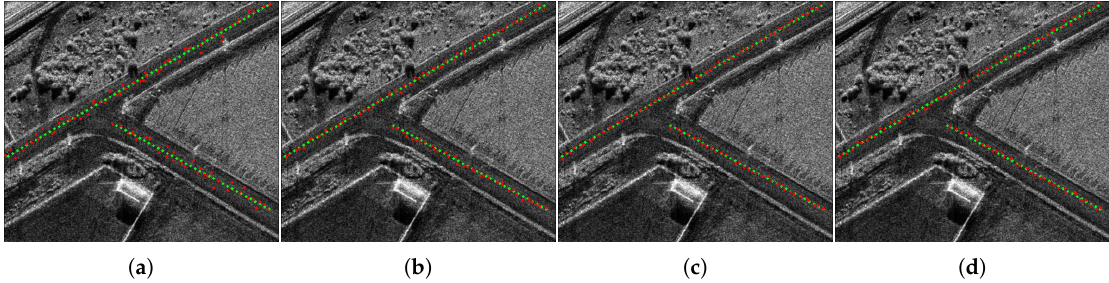
Figure 17. Trajectory reconstruction result on simulated SAR data. Green dots denote true trajectory of target, and red dots represent tracking results. ( a )MOSSE, ( b ) KCF, ( c ) Re 3 , ( d ) SiamFc.